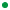
Neutrophil receptor expression with and without bacterial stimulus.(A-J) Neutrophil receptor expression with and without adding fMLF to blood samples of healthy controls (n = 6) (●) and patients with fragile neutrophils (n = 9) (∎). Data are presented as scatter plot with median. Patients with fragile neutrophils were compared to healthy controls with the use of a Mann-Whitney U test. MFI = median fluorescent intensity, fMLF = N-formyl-methionyl- phenylalanine, AU = arbitrary units. *P < 0.05, **P < 0.005, ***P < 0.0005.